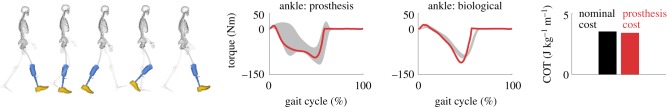
Simulated walking gait of an amputee with a transtibial passive prosthesis. Simulated ankle torques (red curves) matched the average ankle torques of six transtibial amputees [43]. The metabolic cost of transport (COT) for healthy and amputee walking was similar. Experimental data (grey envelopes) are shown as mean ± 2 s.d. The simulations minimized the nominal cost function at an imposed speed of 1.33 m s−1. The prosthesis geometry is for visualization only.